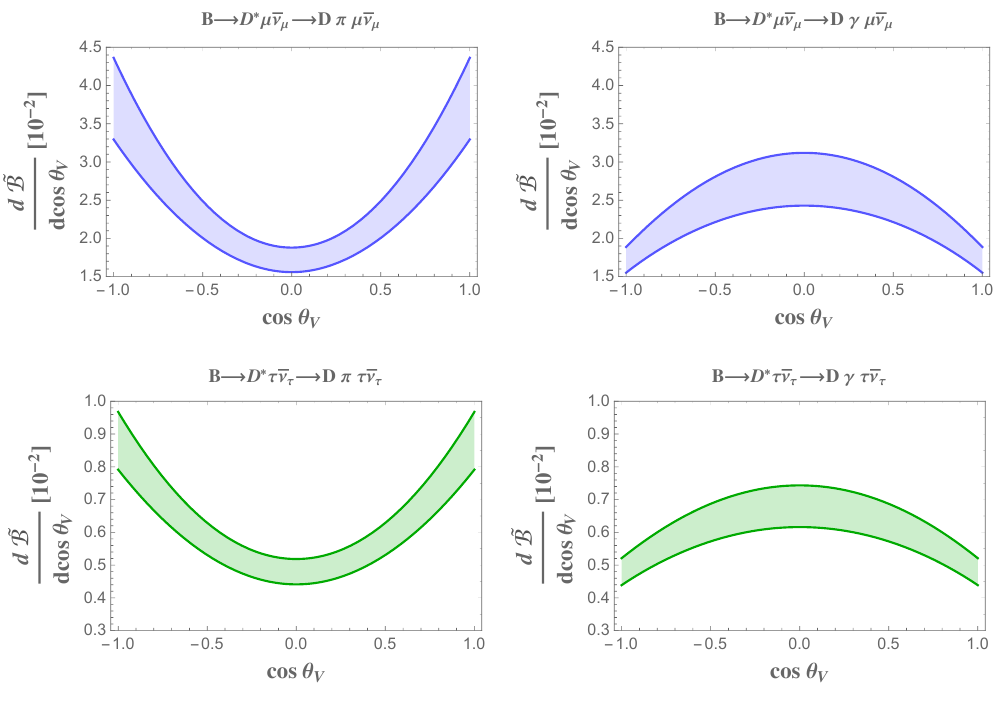
Figure 5 . SM distributions in cos (cid:18) V using CLN, with ~ B = B = B ( D (cid:3) ! DF ). The upper and lower plots refer to ‘ = (cid:22) and ‘ = (cid:28) , respectively, the left and right column to F = (cid:25) and F = (cid:13) .